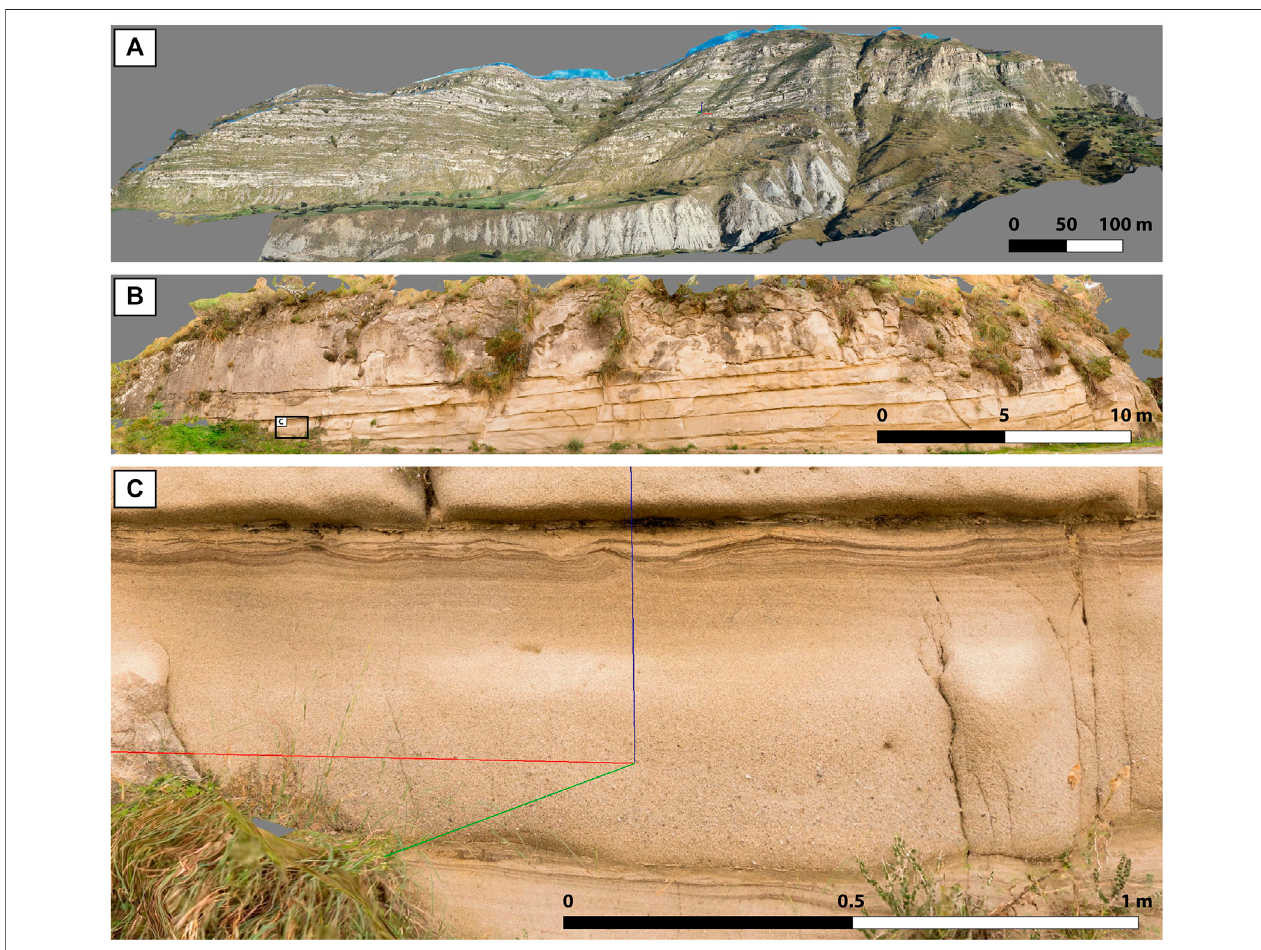
FIGURE 3 | Illustration of the resolution of the 3D drone acquisition dataset (Motta area). The embedded scale used in the present study is presented, from panoramic stratigraphic architectures of the Motta area (A) , to bed sets (B) and individual beds (C) . Figure 3C corresponds to the black rectangle on Figure 3B .